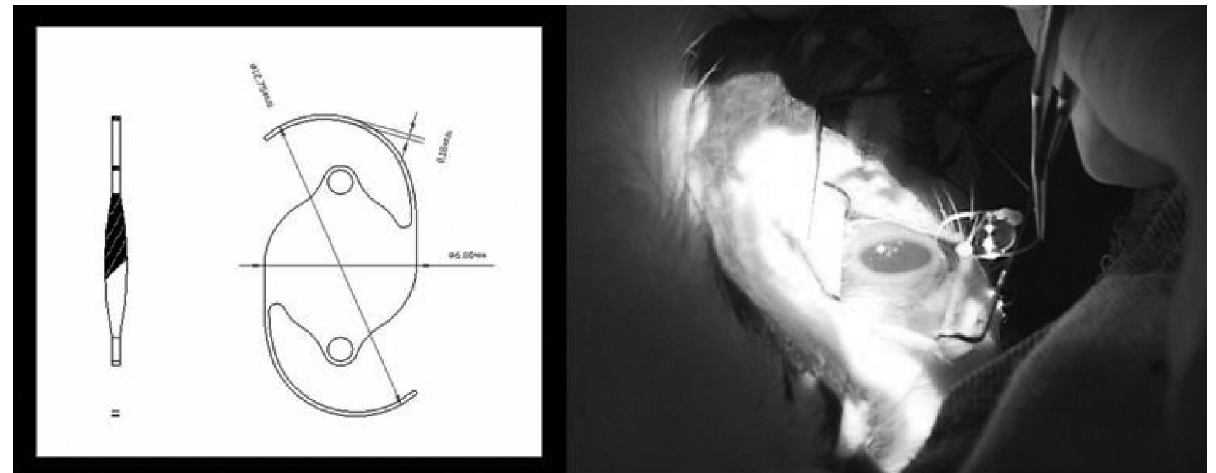
FIGURE 3 - Schematic representation of IOL containing the rings for implant insertion (A) and photography showing the implantation of the IOL containing the biodegradable implant